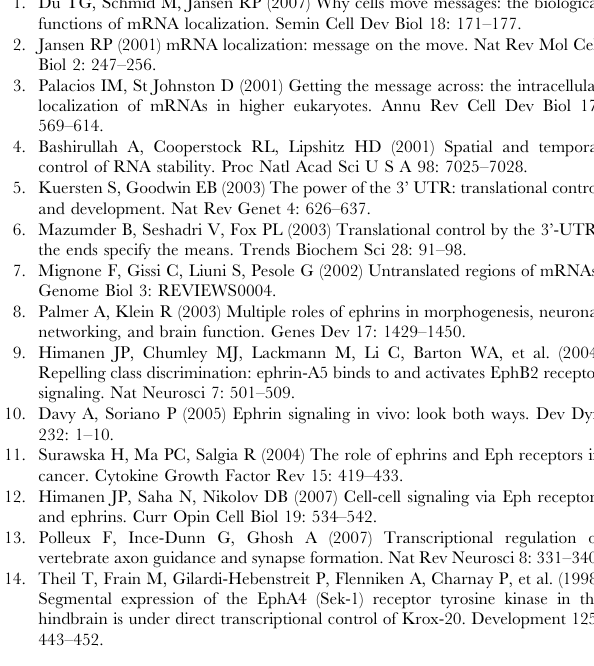
Table S1 Lengths of Eph/ephrin 3’UTRs and accession